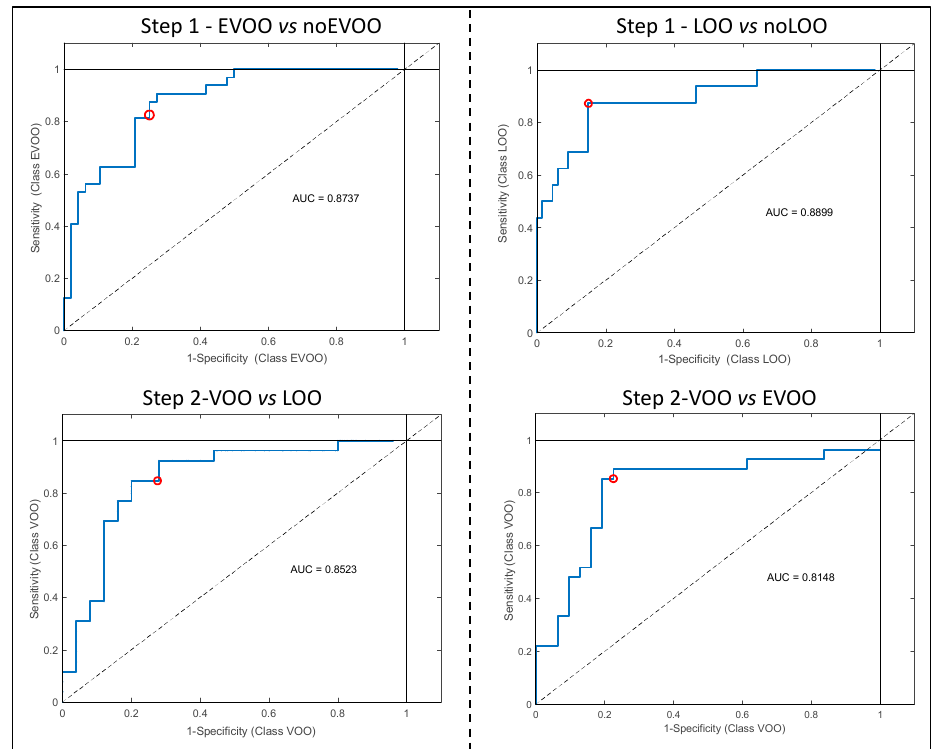
Figure 1. Receiver operating characteristic (ROC) curves of all developed PLS-DA models used to